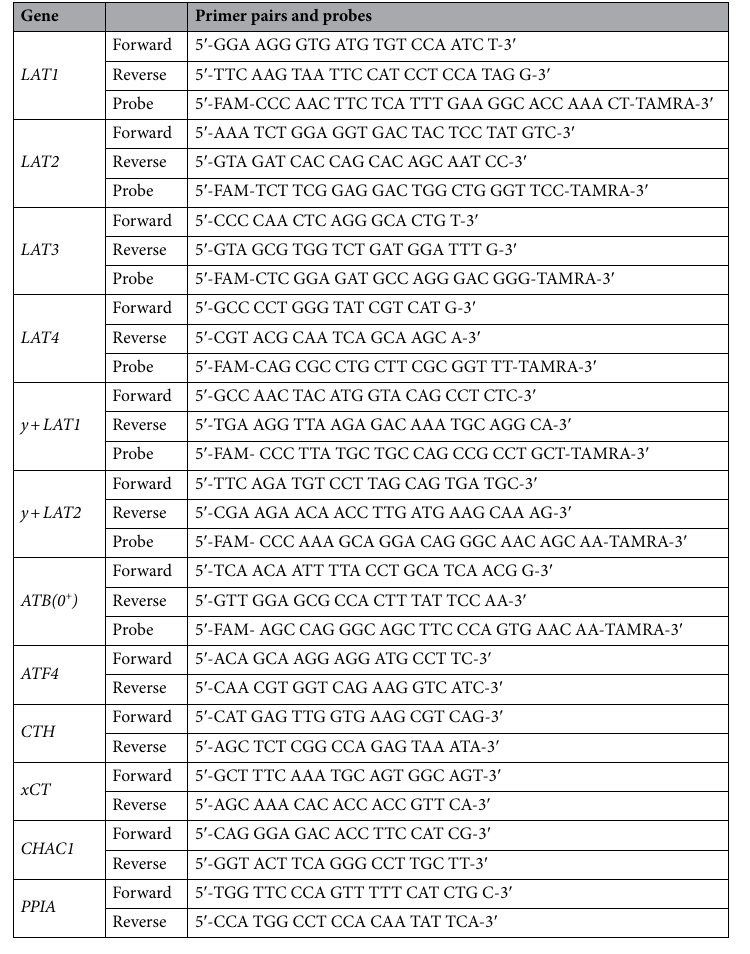
Table 3. Primer pairs and probes for real-time